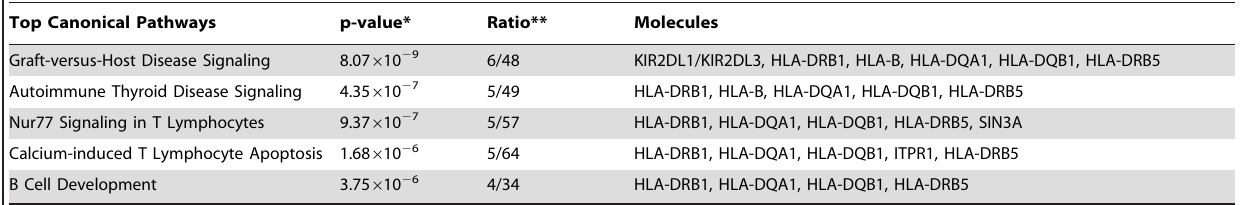
Table 3. Pathway analysis.